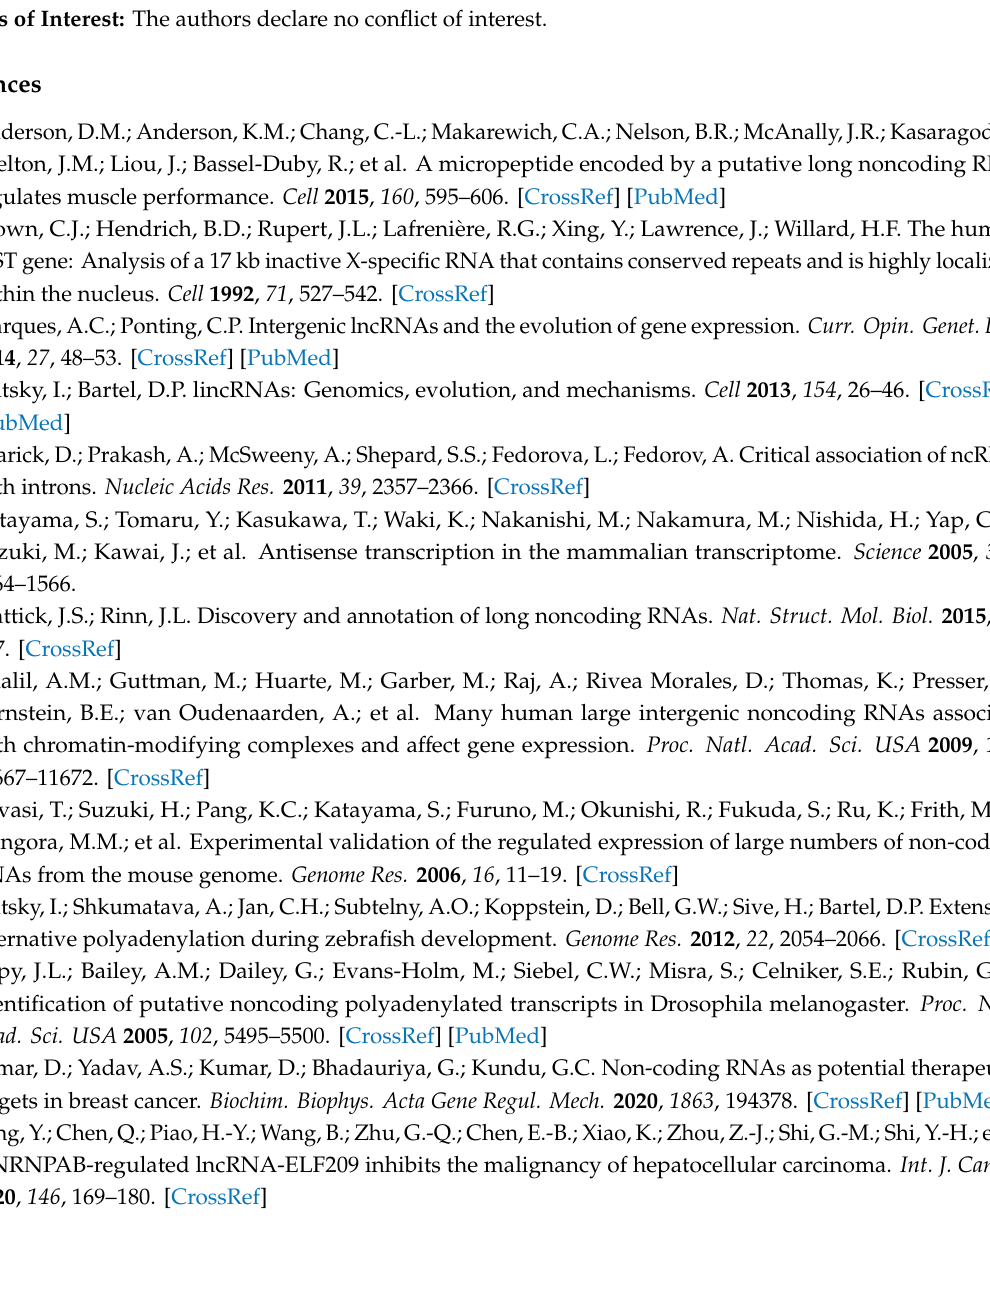
Table S4. The match quality to genome of sequencing data. Table S5. The top 20 signaling pathways enriched by the colocalized genes of di ff erentially expressed lncRNAs from pairwise comparison “B vs. S1”: “Sample number” was the number of colocalized genes of di ff erentially expressed lncRNAs relative with the signaling pathway. “Background number” was the number of genes in the signaling pathway. “UniGenes” were the predicted target genes of lncRNAs. Table S6. The top 20 signaling pathways enriched by the colocalized genes of di ff erentially expressed lncRNAs from pairwise comparison “S1 vs. S2”. Table S7. The top 20 signaling pathways enriched by the colocalized genes of di ff erentially expressed lncRNAs from pairwise comparison “S2 vs. S3”. Table S8. The top 20 signaling pathways enriched by the colocalized genes of di ff erentially expressed lncRNAs from pairwise comparison “I vs.